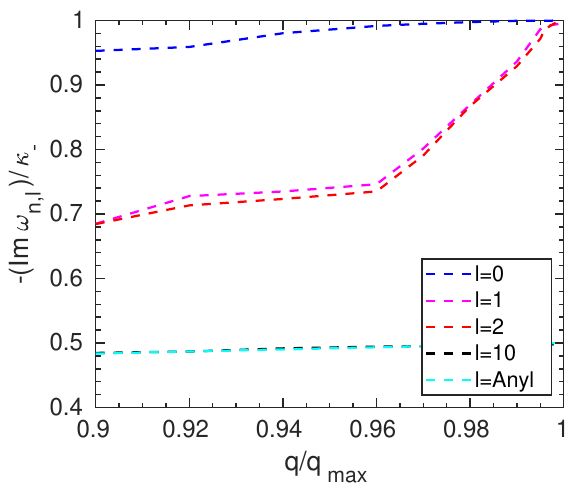
Figure 1 . Here we have plotted the ratio {− ( Im ω n,l ) /κ − } against ( q/q max ) for different values of the angular momentum ‘ . The lowest lying curve depicts β and as evident is less than the critical value (1/2). Here we have taken the values of the AdS length scale and the mass of the black hole to be L = M = 1 .